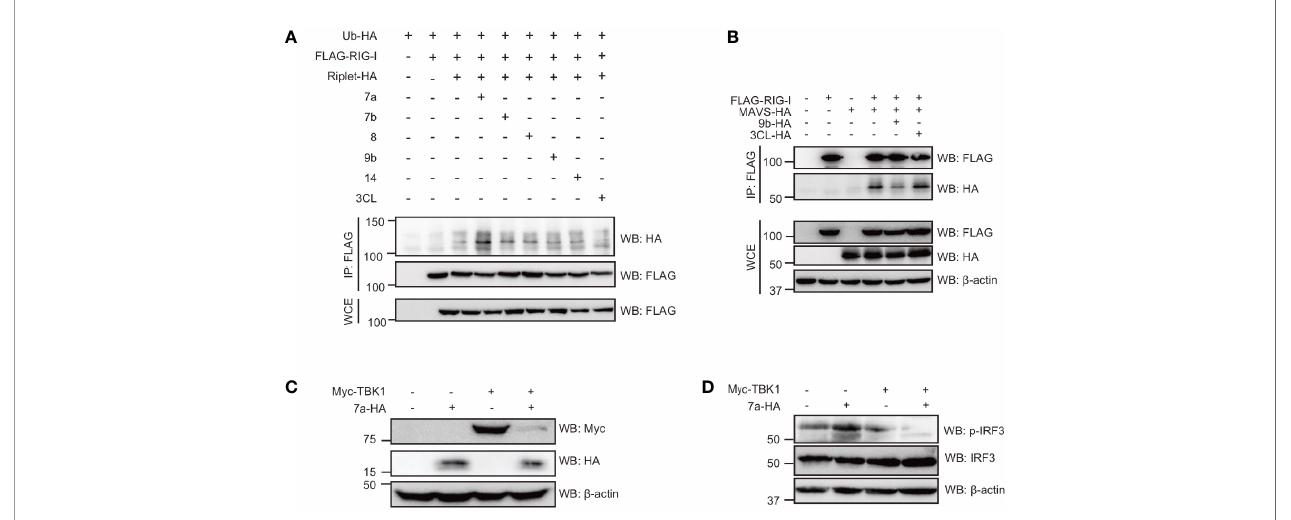
FIGURE 6 | The viral protein targeted the components involved in RIG-I signaling. (A) HEK293FT cells were transfected with HA-tagged ubiquitin (HA-Ub), FLAG- tagged RIG-I, HA-tagged Riplet, viral ORF 7a, 7b, 8, 9b, 14, and 3CL expression vectors for 24 h as indicated, and then whole cell extract (WCE) was prepared. Immunoprecipitation was performed using an anti-FLAG antibody. The proteins were subjected to SDS-PAGE and detected by Western blotting with indicated antibodies. (B) HEK293FT cells were transfected with FLAG-tagged RIG-I, HA-tagged MAVS, viral 9b, and 3CL for 24 h, and then WCE was prepared. Immunoprecipitation was performed with anti-FLAG antibodies. The proteins were subjected to SDS-PAGE and detected by Western blotting. The data shown is representative of two independent experiments. (C, D) HEK293FT cells were transfected with myc-tagged TBK1 and viral 7a proteins for 24 h, and then WCE was prepared. The proteins were subjected to SDS-PAGE and detected by Western blotting as indicated antibodies. The data shown is representative of at least two independent